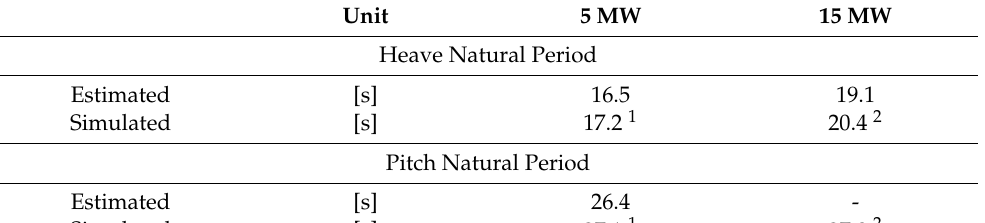
Table 1. Estimated (present) and simulated [4,16] natural periods for reference semi-submersibles.